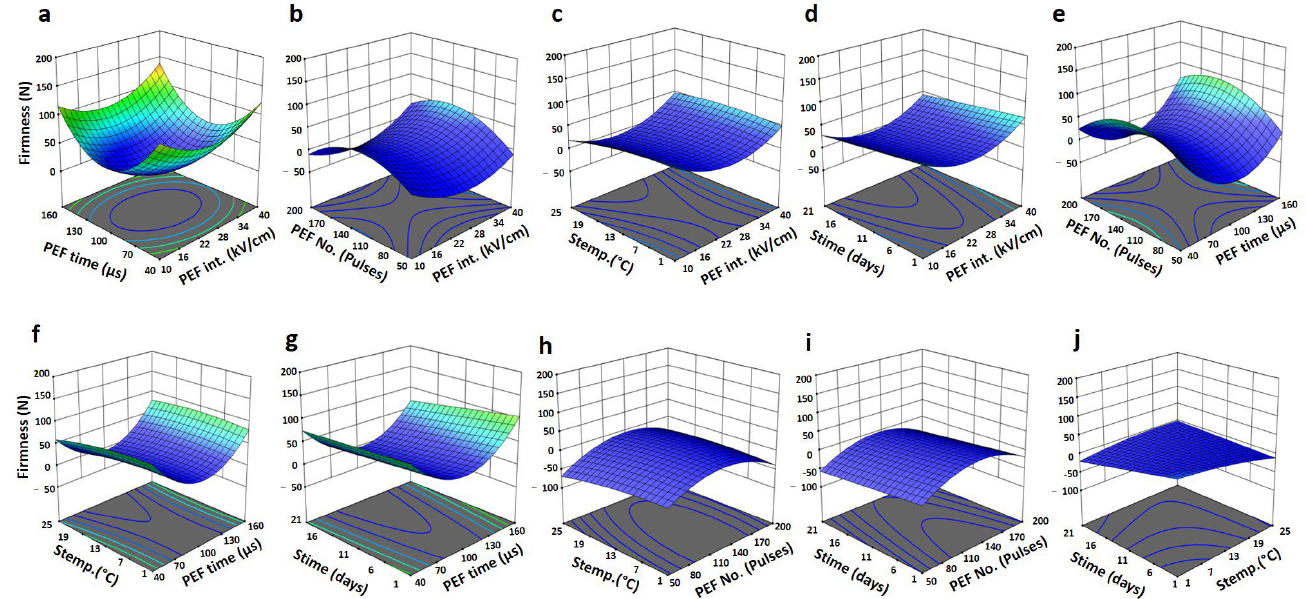
Figure 3. Response surface plots of firmness of Barhi dates as a function of PEF time and PEF intensity ( a ), PEF number of pluses and PEF intensity ( b ), storage temperature and PEF intensity ( c ), storage time and PEF intensity ( d ), PEF number of pulses and PEF time ( e ), storage temperature and PEF time ( f ), storage time and PEF time ( g ), storage temperature and PEF number of pulses ( h ), storage time and PEF number of pulses ( i ), and storage time and storage temperature ( j ).